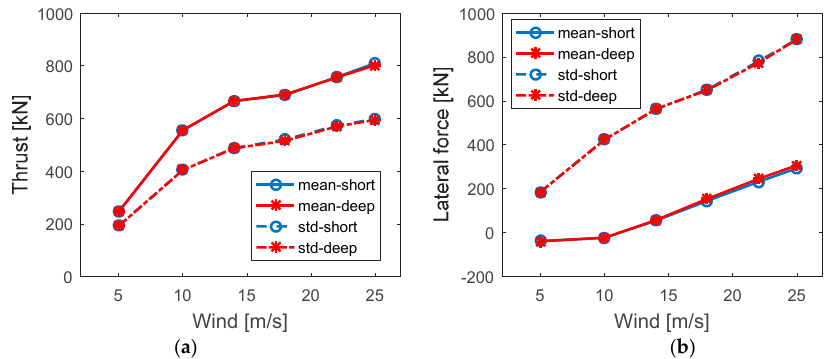
Figure 7. Comparison of mean values and standard deviations of the 2P loading for the short and deep spar VAWTs under all loading cases: ( a ) Thrust; ( b ) Lateral force.